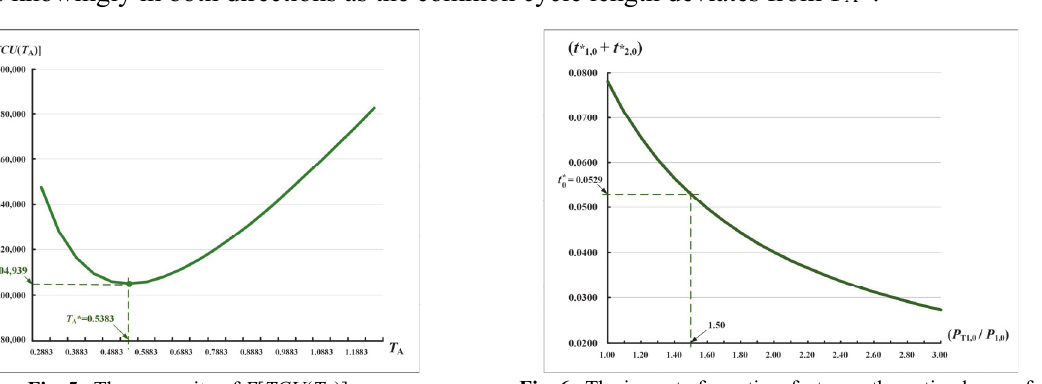
Fig. 5. The convexity of E [ TCU ( T A )] Fig. 6. The impact of overtime factor on the optimal sum of uptime and rework time ( t 0 *) in stage 1